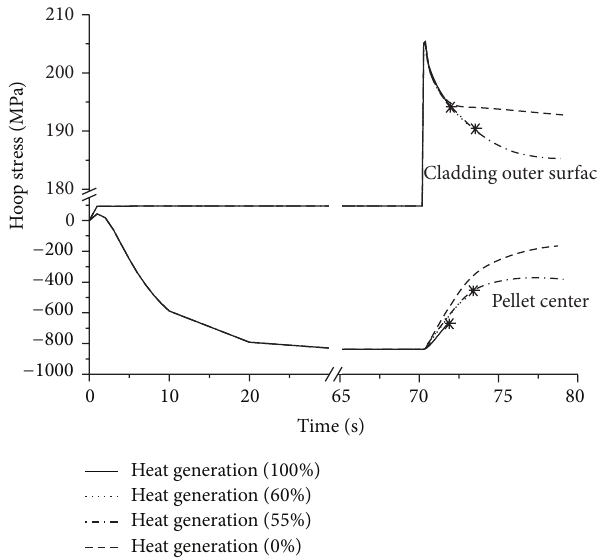
Figure 12: Hoop stresses changes at pellet center and cladding outer surface after LOCA at 70sec.